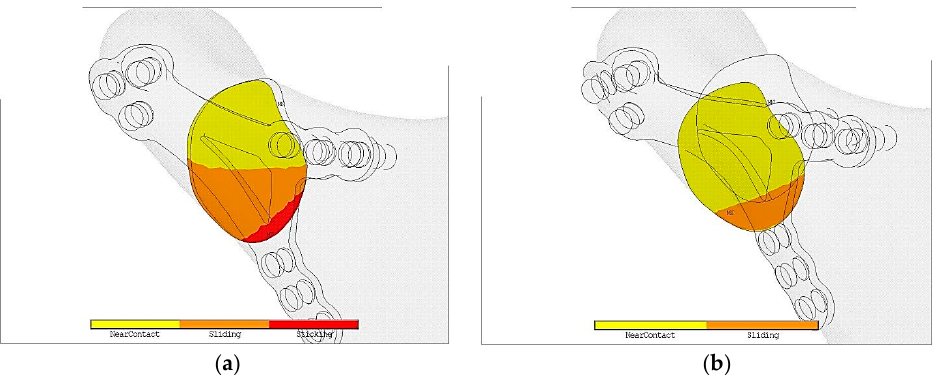
Figure 4. Contact status just after following plate fixation in the maximal loading according to